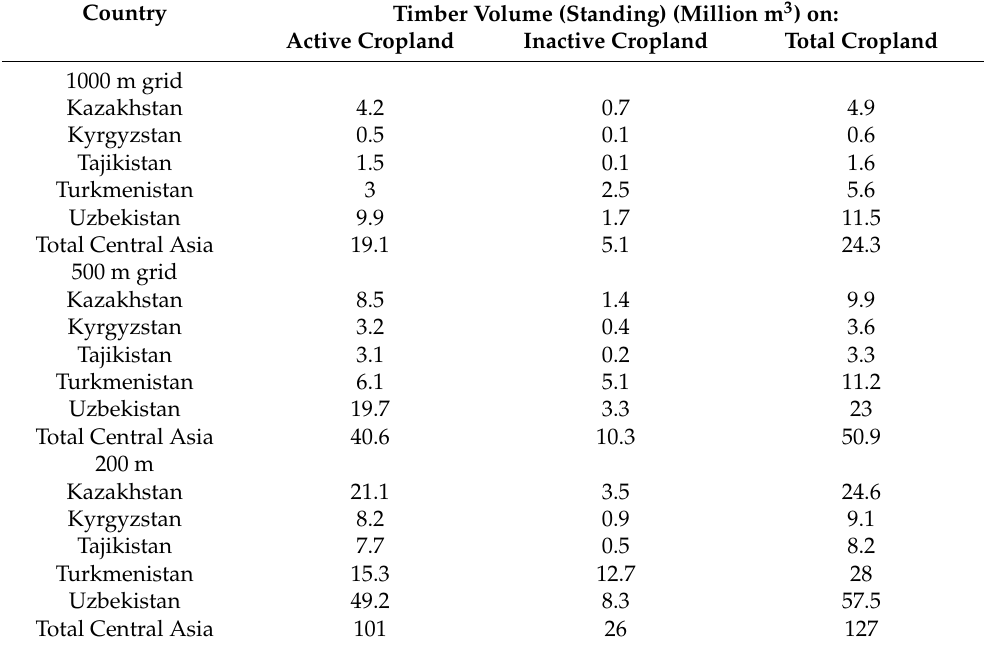
Table 5. Timber volume (standing) under 1000 m, 500 m, 200 m grids by country (million m 3 ), current adoption (26% of the potential tree windbreaks realized). Country Timber Volume (Standing) (Million m 3 )